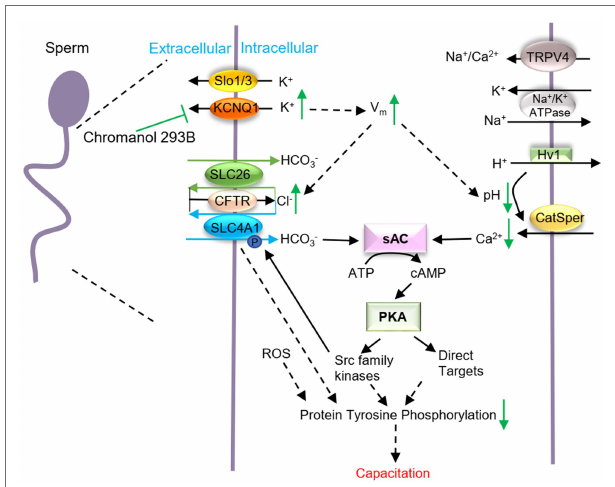
FIGURE 5 | Schematic representation of how KCNQ1 potassium channel regulates human sperm function. When human sperm are treated with chromanol 293B, the K + outflow currents mediated by KCNQ1 are inhibited, which causes a [K + ] i increase and the membrane depolarization. V m changes regulate other voltage-gated channels and affect the electrical driving force for ions. Thus, [Cl − ] i increases, while the pH i and [Ca 2+ ] i decreases. It is generally known that during capacitation, Ca 2+ and HCO 3 − activate soluble adenylate cyclase (sAC) which converts ATP into cAMP. Then PKA can be activated. PKA subsequently activates target proteins and protein tyrosine phosphorylation levels increase. KCNQ1 in human sperm participates in ion homeostasis regulation and affects